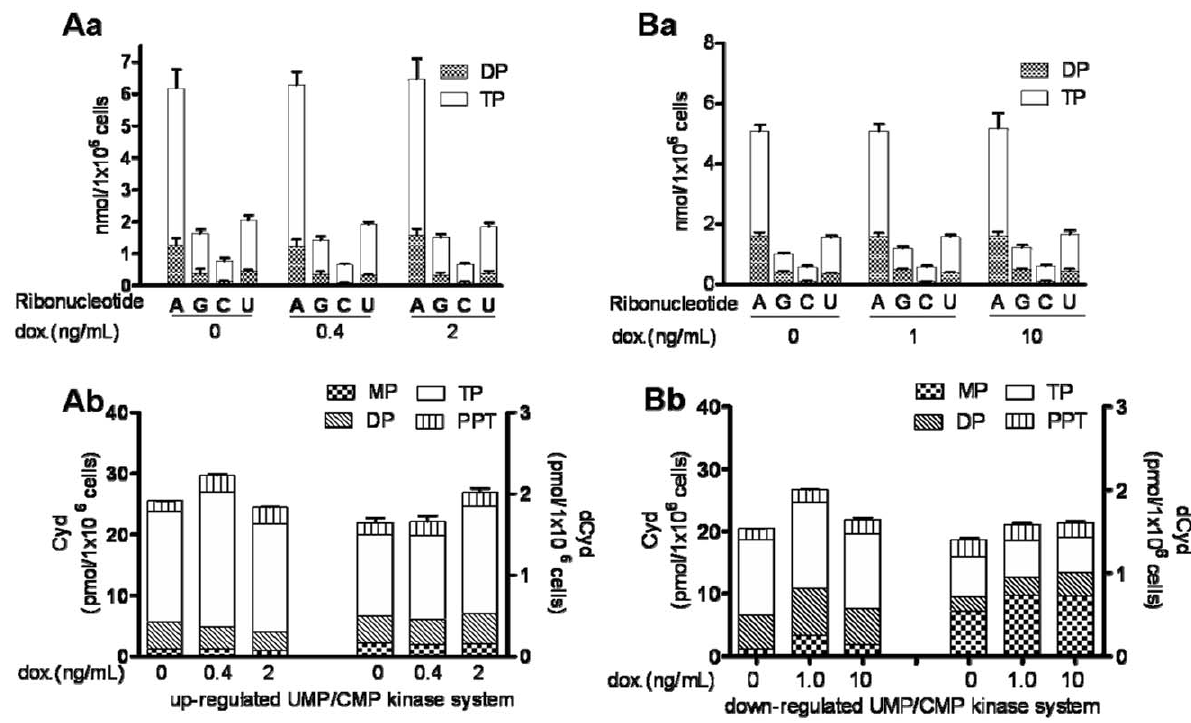
Figure 2. Evaluation of endogenous ribonucleotide pool profile and metabolism of exogenous Cyd and dCyd in RKO cells overexpressing or underexpressing UMP/CMP kinase. Aa. the content of ribonucleoside di- and triphosphates in cells overexpressing UMP/ CMP kinase. Ab. the amounts of Cyd and dCyd metabolites as well as the amounts of their incorporation into DNA (PPT) in cells overexpressing UMP/ CMP kinase. Ba. the content of ribonucleoside di- and triphosphates in cells underexpressing UMP/CMP kinase. Bb. the amounts of metabolites of Cyd and dCyd as well as the amounts of their incorporation into DNA (PPT) in cells underexpressing UMP/CMP kinase.